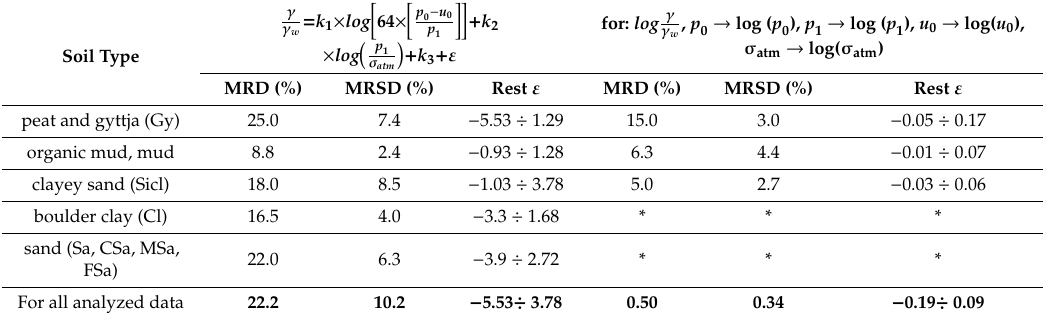
Table 8. Comparison of MRD, MRSD, and the rest of the obtained values before and after transformation for Equation (13).